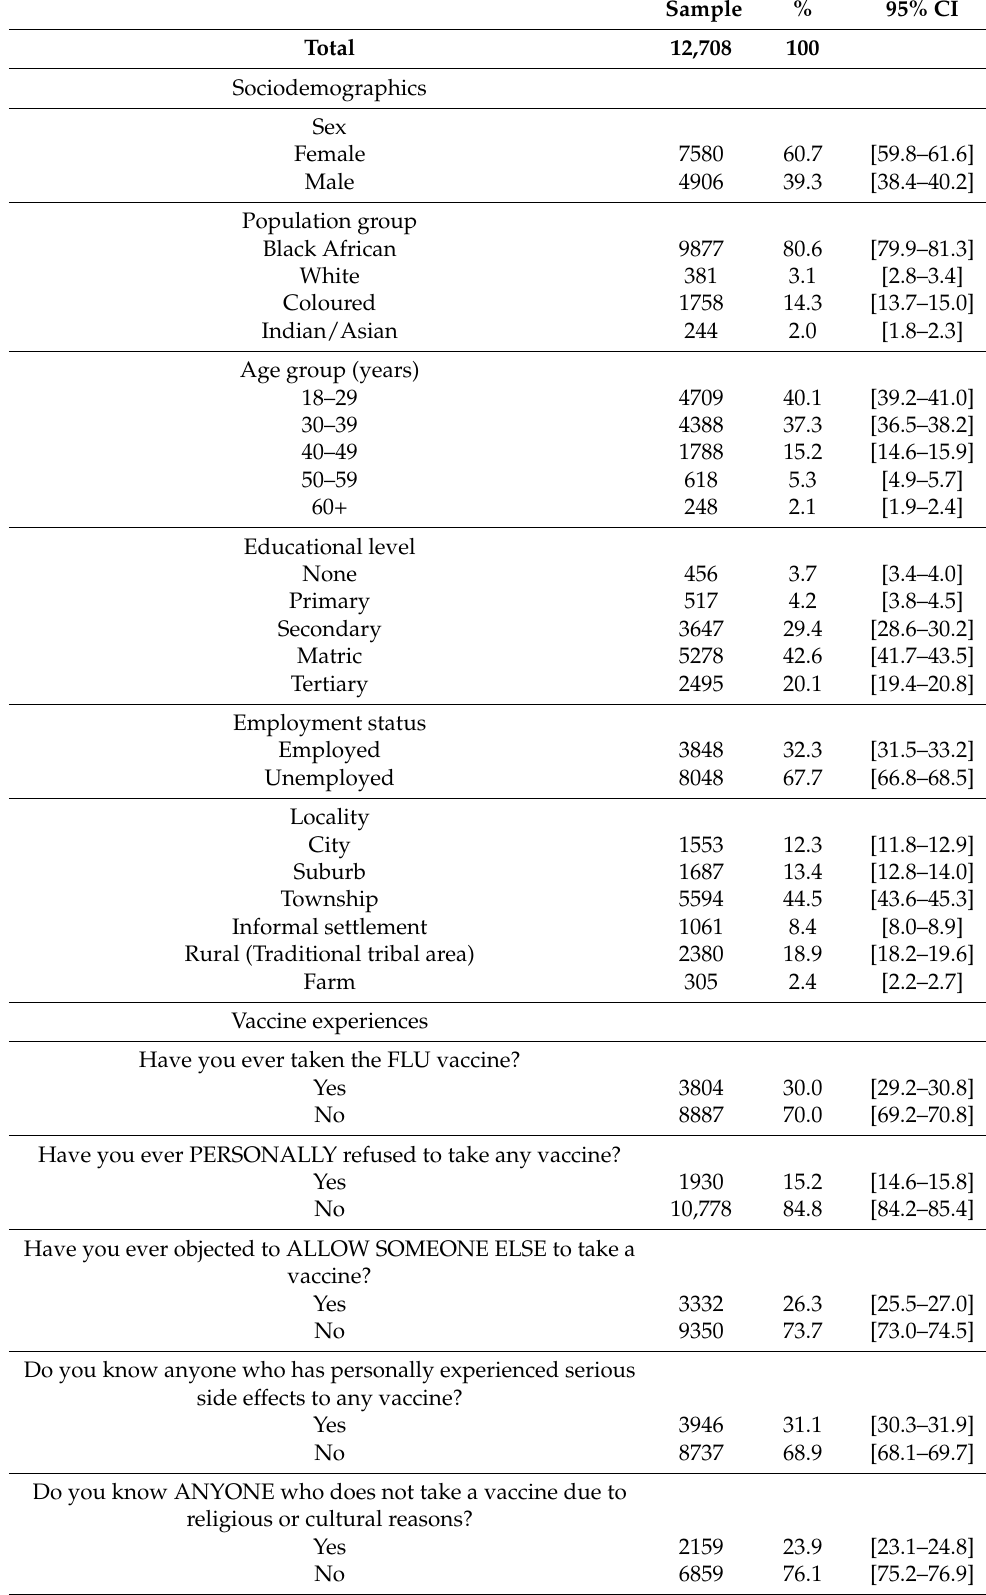
Table 2. Characteristics of the study